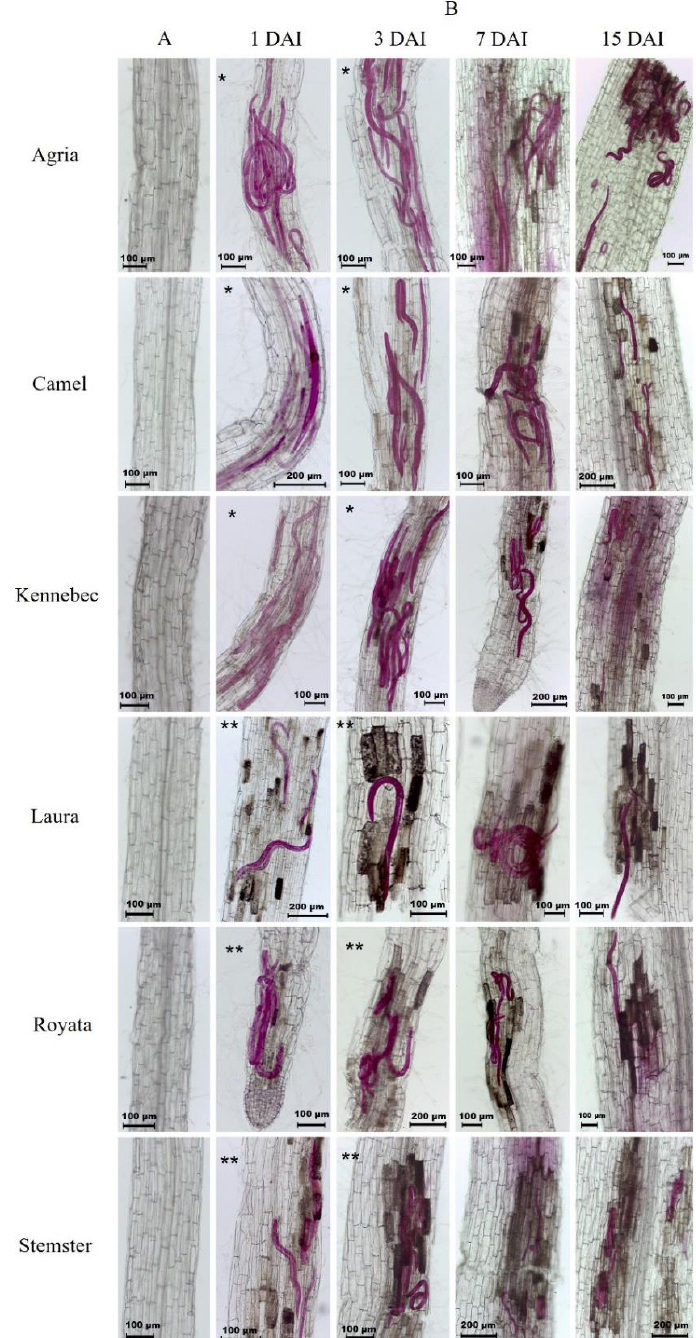
Figure 1. Symptoms of early root penetration of Pratylenchus penetrans in six cultivars of potato, Solanum tuberosum : ( A ) non-inoculated control plants; ( B ) nematode-infected potato plants at 1, 3, 7, and 15 days after inoculation (DAI) with 750 P. penetrans mixed stages/plant. Slight to moderate browning of the punctuated or penetrated cells by the nematode in cultivars Agria, Camel, and Kennebec (*), and severe cell browning reaction in Laura, Royata, and Stemster (**) at the early time points 1, 3